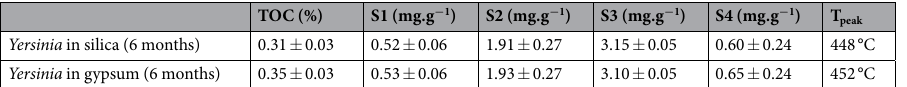
Table 2. Main thermal maturity properties of the organic carbon in samples after 6 months mineralization in silica or in gypsum, as determined by Rock-Eval analysis. Total Organic Carbon (TOC) is given in percent. S1 represents free hydrocarbons, S2 the hydrocarbons generated during heating, S3 the CO 2 released by thermal breakdown of molecules and S4 the refractory residual carbon. T peak represents the temperature leading to the maximum detection of